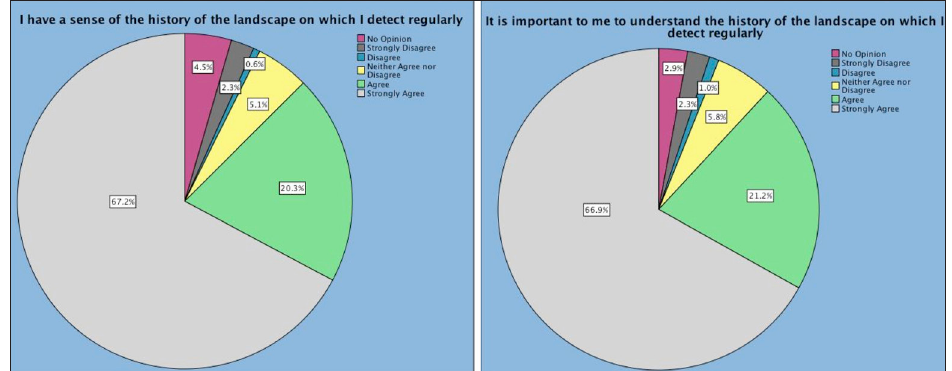
Figure 4: How many respondents agreed with the statements: ‘I have a sense of the history of the landscape on which I detect regularly’ (n = 311), and ‘It is important to me to under- stand the history of the landscape on which I detect regularly’ (n =